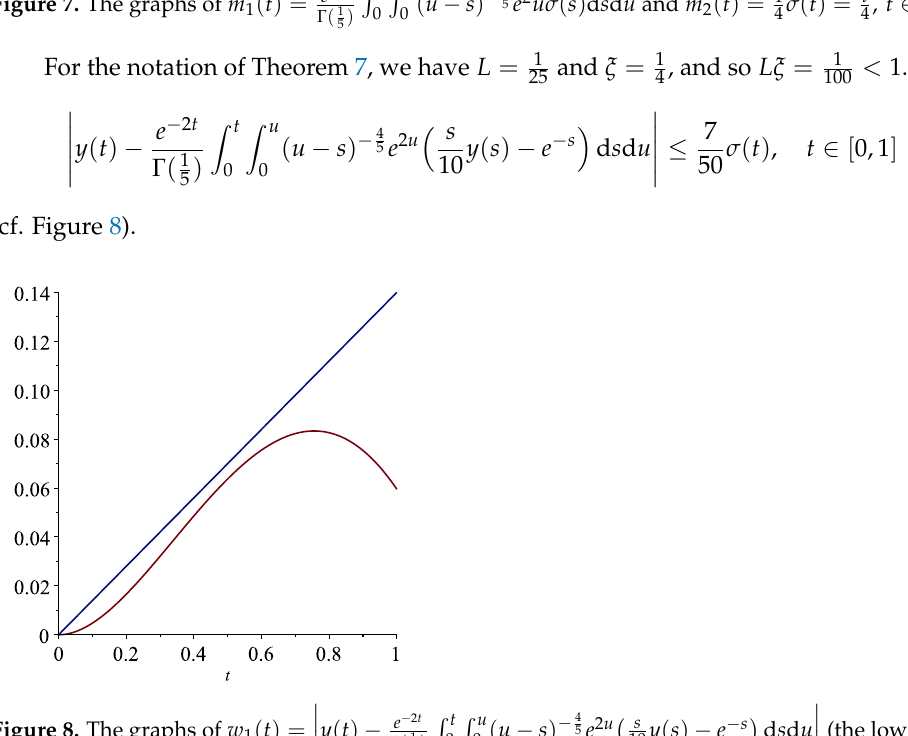
Figure 7. The graphs of m 1 ( t ) = e − 2 t